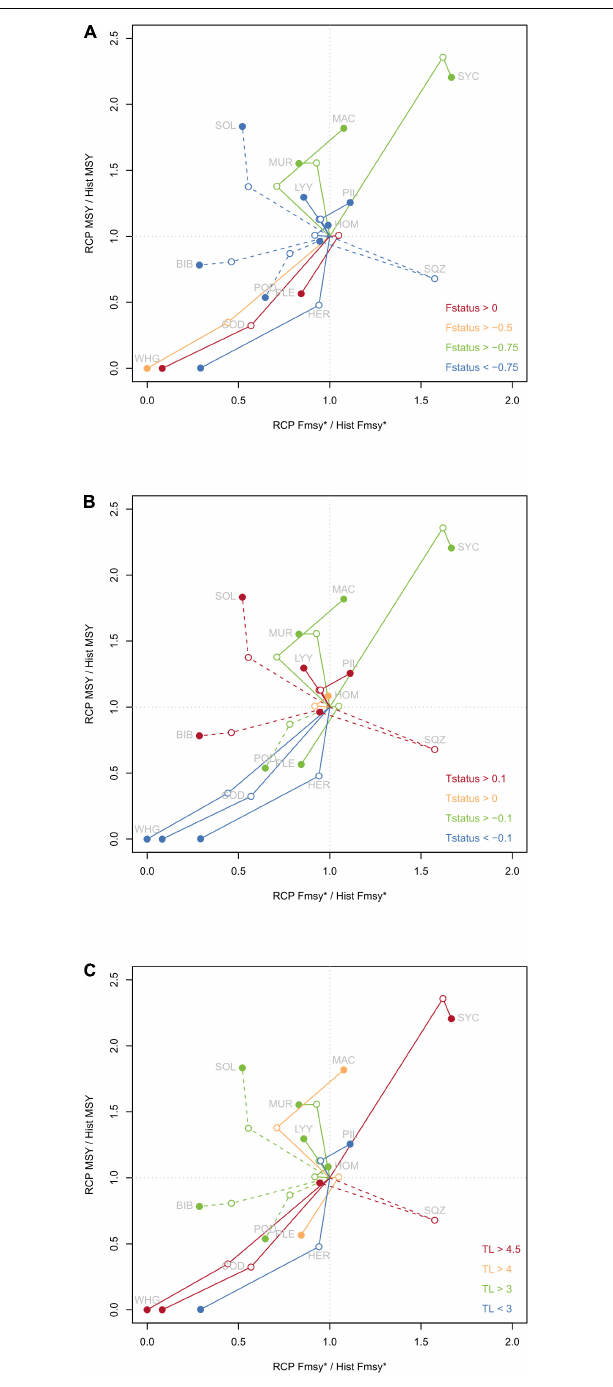
FIGURE 3 | Evolution of reference points under climate change scenarios compared to historical values of reference points. Relative MSY is plotted on the y -axis. Relative F MSY * corresponds to relative F MSY for most species and to relative F 95 MSY for species displaying a plateau in their catch-F curve, and is displayed on x -axis. Dashed lines indicate those species. Historical references points are situated at coordinates (1,1) by construction, references points under RCP 4.5 are indicated by open dots and reference points under RCP 8.5 are indicated by filled dots. Colors are associated to species characteristics, either F status (A) , T ◦ status (B) or TL (C)